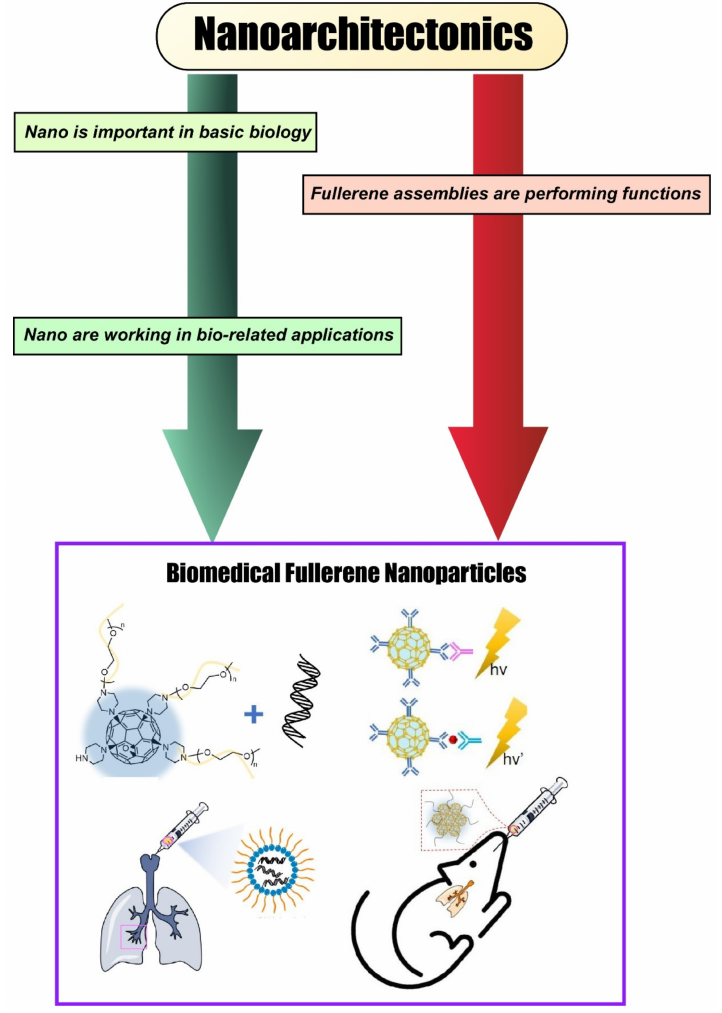
Figure 2. Outline and story flow of this review article. First, we present nanoscale interactions in biology and bio-related applications, giving an overview of how they fit into the nanoarchitectonics framework for materials design and synthesis. Then, we take a deep dive into a particular building- block material frequently seen in nanoarchitectonics approaches: fullerene; we take a closer look at recent research on fullerene nanoparticles, paying special attention to biomedical applications in biosensing, gene delivery, and radical